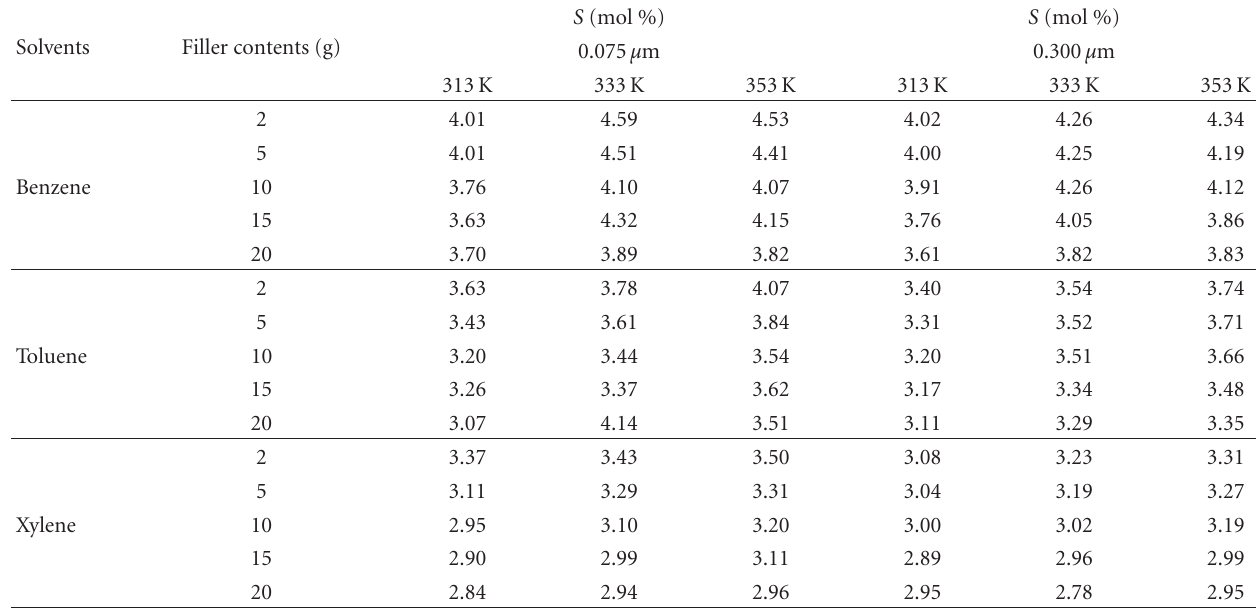
Table 3: Values of the sorption coe ffi cient ( S ) for snail shell powder filled natural rubber at di ff erent temperatures (filler particle sizes 0.075 and 0.300 μ m).